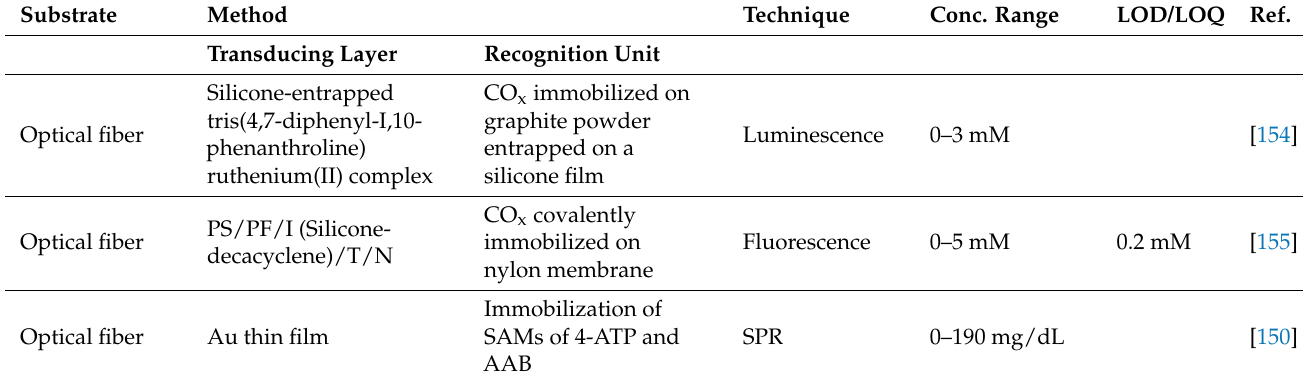
Table 3. Various fiber optic cholesterol sensors reported in